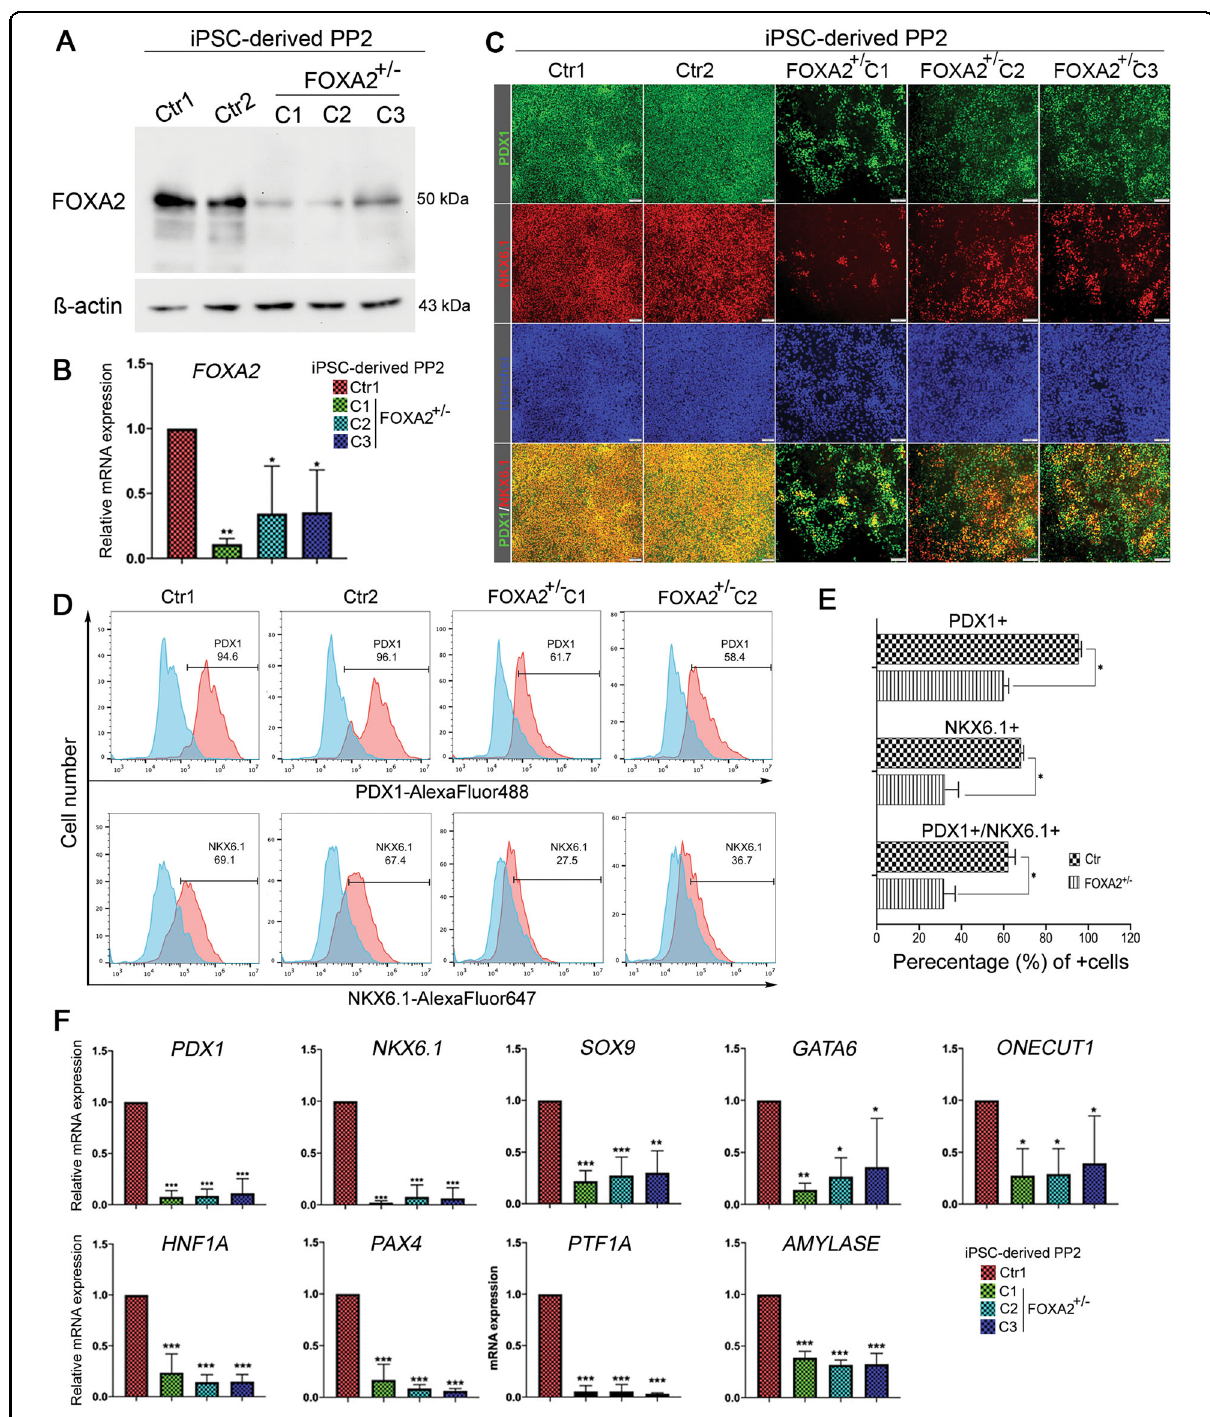
Fig. 2 Effect of FOXA2 haploinsuf fi ciency on pancreatic progenitor (PP2) differentiation. Western blotting ( A ) and qPCR analysis ( B ) for FOXA2 protein and mRNA expression levels in iPSC-derived PP2. C Representative immuno fl uorescent images showing the expression of PDX1 and NKX6.1 in the PP2 derived from Ctr-iPSCs and FOXA2 + / − iPSCs. D Flow cytometry histograms showing the expression of PDX1 and NKX6.1 in the PP2 derived from Ctr-iPSCs and FOXA2 + / − iPSCs. E Quanti fi cation of the expression of PDX1 and NKX6.1 shown in D . F qPCR quanti fi cation for the expression of key PP2 markers, PDX1 , NKX6.1 , SOX9 , HNF1A , GATA6 , PAX4 , ONECUT1 (HNF6) , PTF1A , and AMYLASE in the generated PP2. Data are represented as mean ± SD; * p < 0.05, ** p < 0.01, *** p <